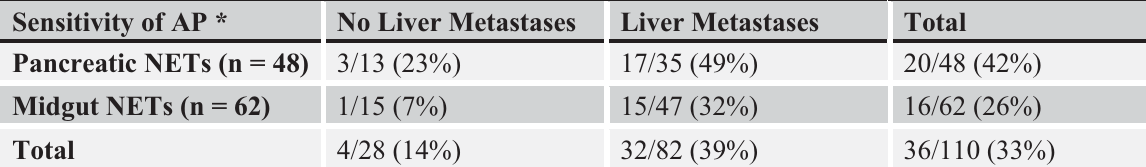
Table 5. Sensitivities of AP (number of patients with median AP values above reference range/number of all patients of the corresponding group) depending on tumor primary and hepatic metastatic